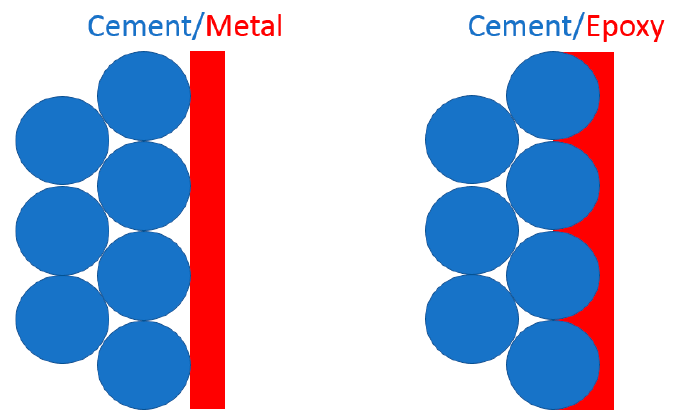
Figure 6. Typical higher magnification SEM (SE) images depicting homogeneous distribution of carbon nanofibers in sample K1 and aggregates of fibers in sample K2. nanofibers in sample K1 and aggregates of fibers in sample K2.